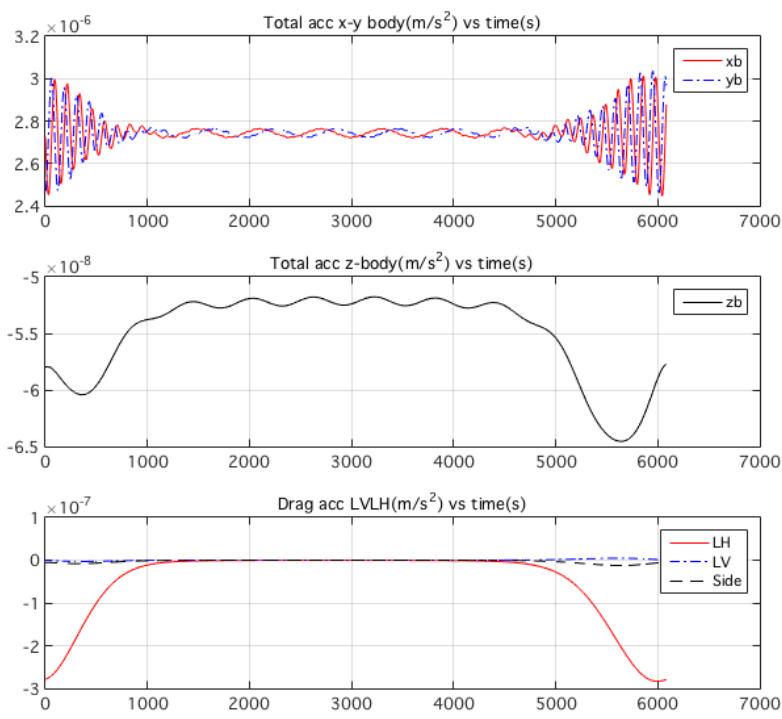
Figure 4. Total acceleration measured by x-body and y-body ( top ) and z-body ( middle ) accelerometer sensing elements and simulated air drag acceleration components ( bottom ), over one orbit.